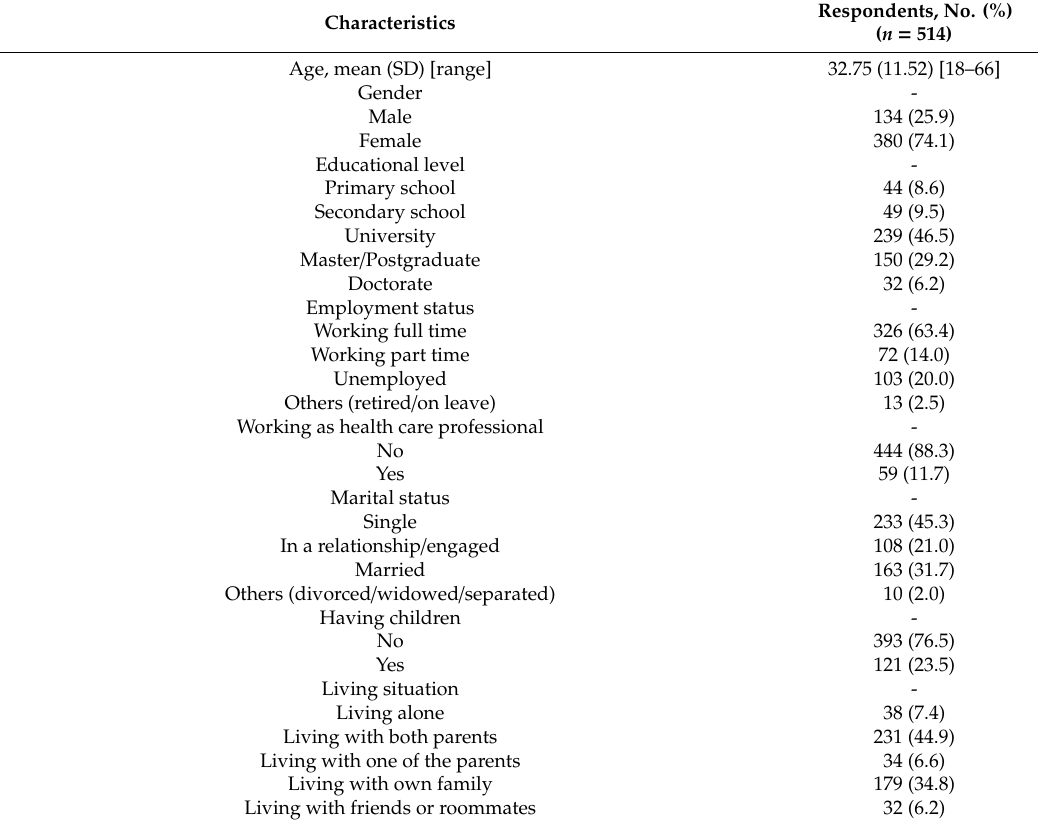
Table 1. Characteristics of the